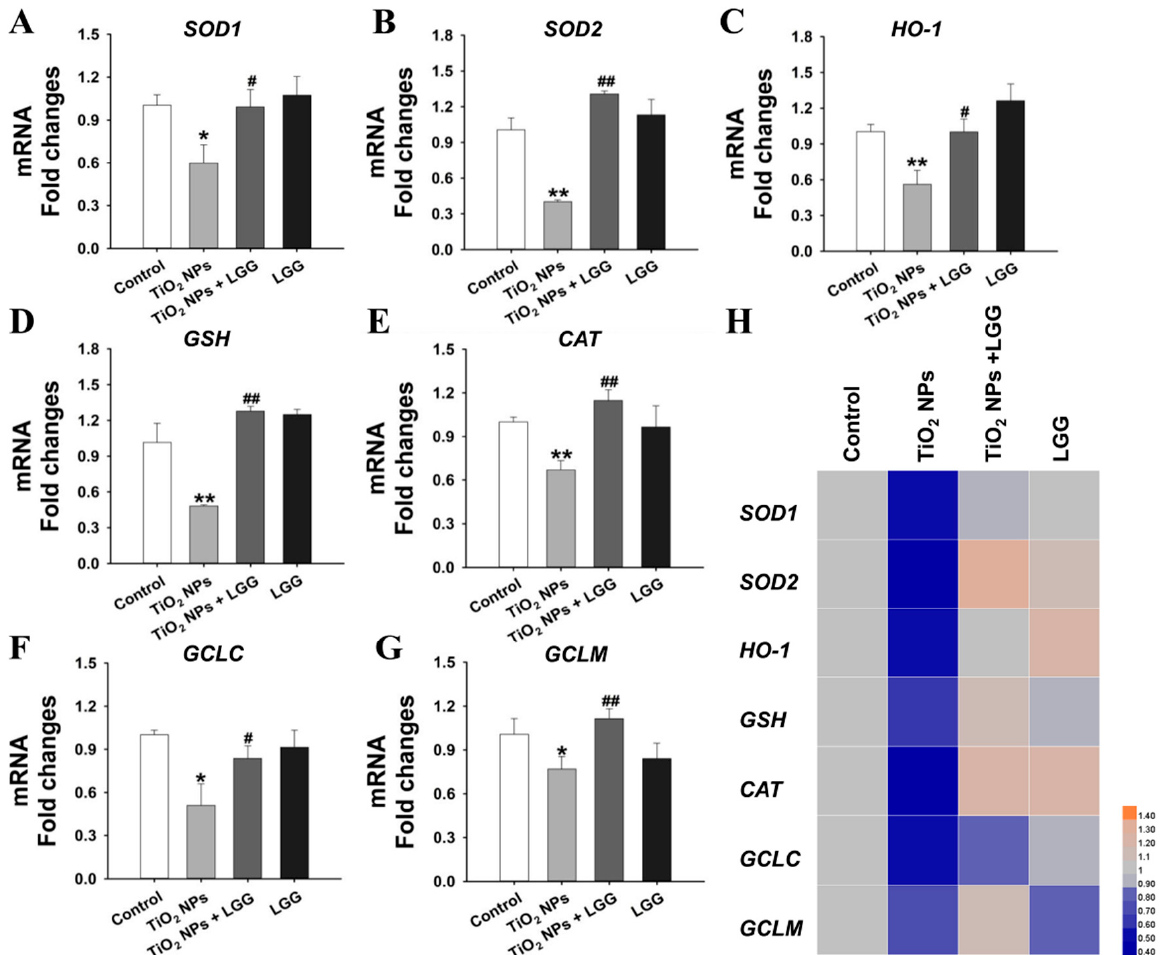
Figure 7. Expression of genes related to OS in the liver of young rats after oral exposure to TiO 2 NPs. ( A ) SOD-1 . ( B ) SOD-2 . ( C ) HO-1 . ( D ) GSH . ( E ) CAT . ( F ) GCLC . ( G ) GCLM . ( H ) Gene thermogram: blue represents low expression and yellow represents high expression, * p < 0.05 and ** p < 0.01 versus the control group; # p < 0.05 and ## p < 0.01 versus the TiO 2 NPs group. n = 3, values are expressed as mean ± SD.